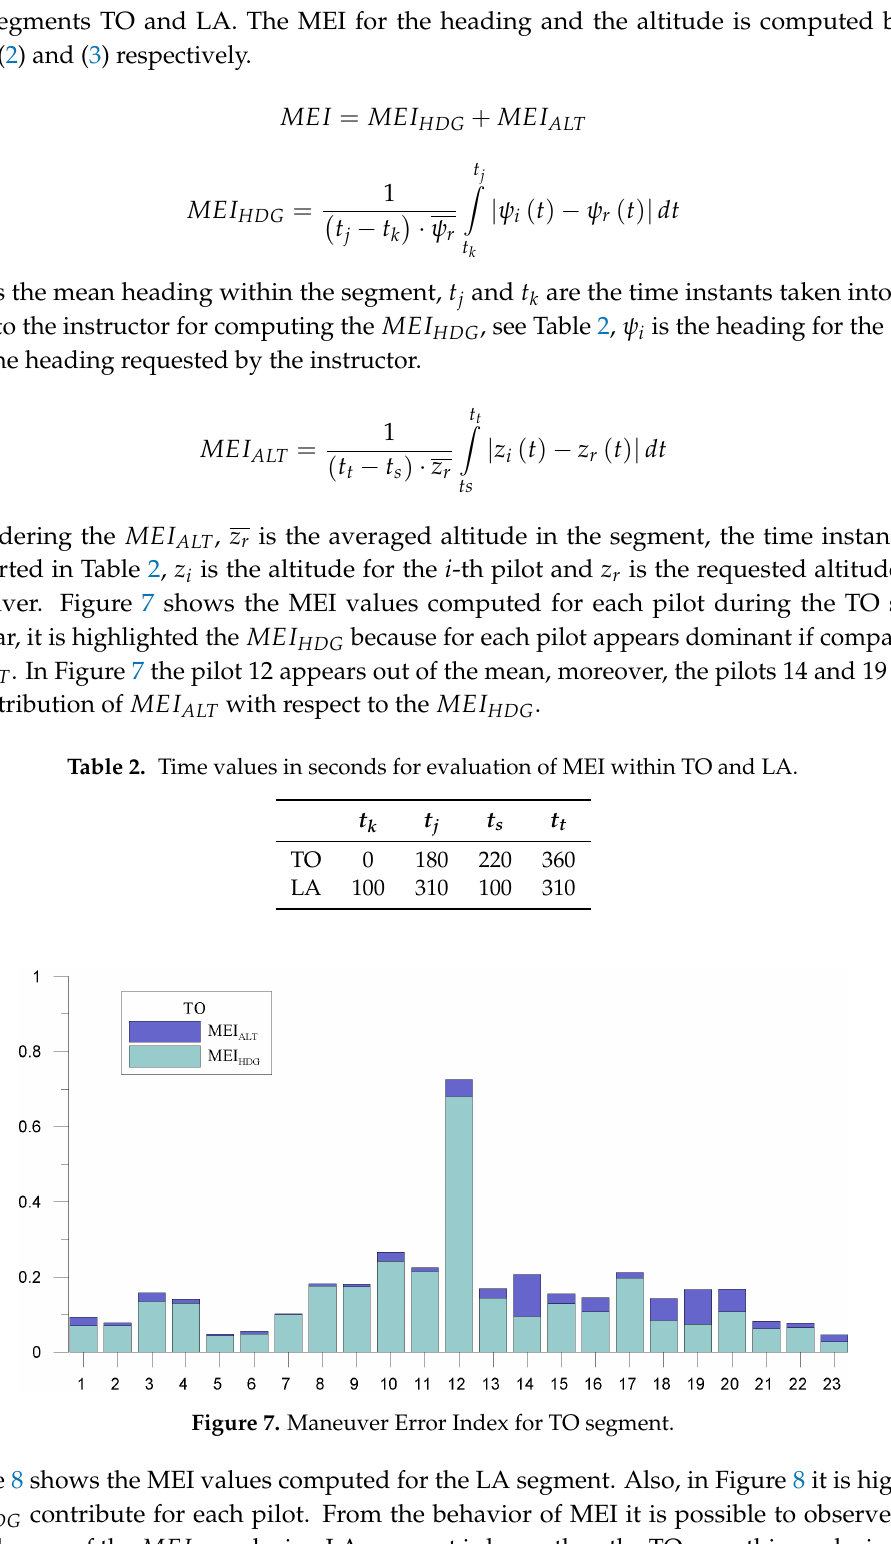
Figure 7. Maneuver Error Index for TO